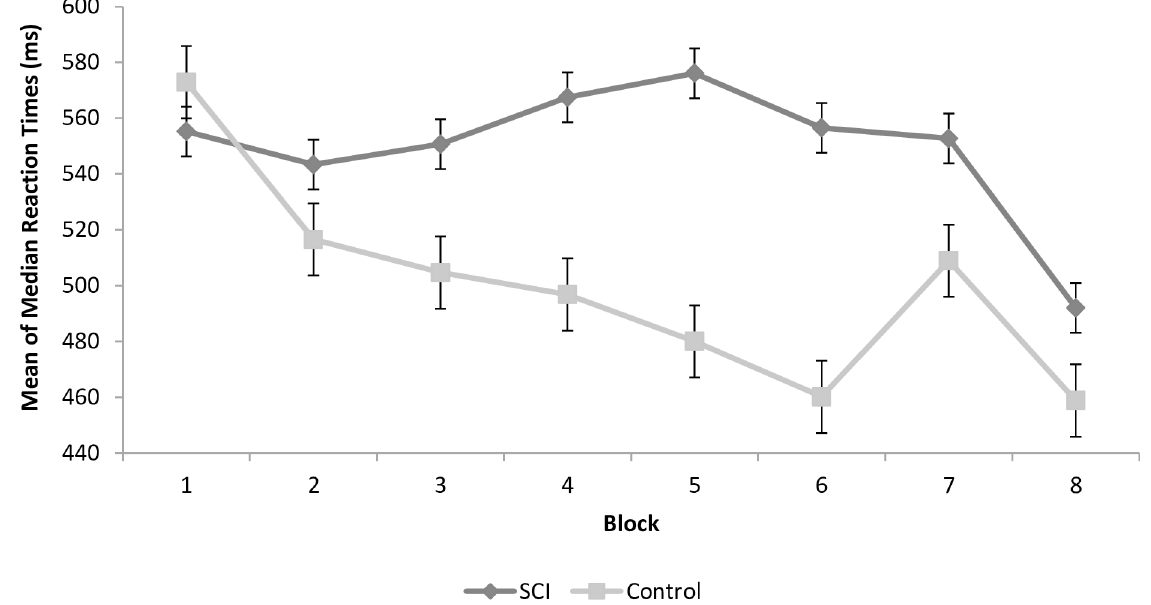
Fig 2. Serial Reaction Time (SRT) task performance (mean and SEM) in the spinal cord injury and control